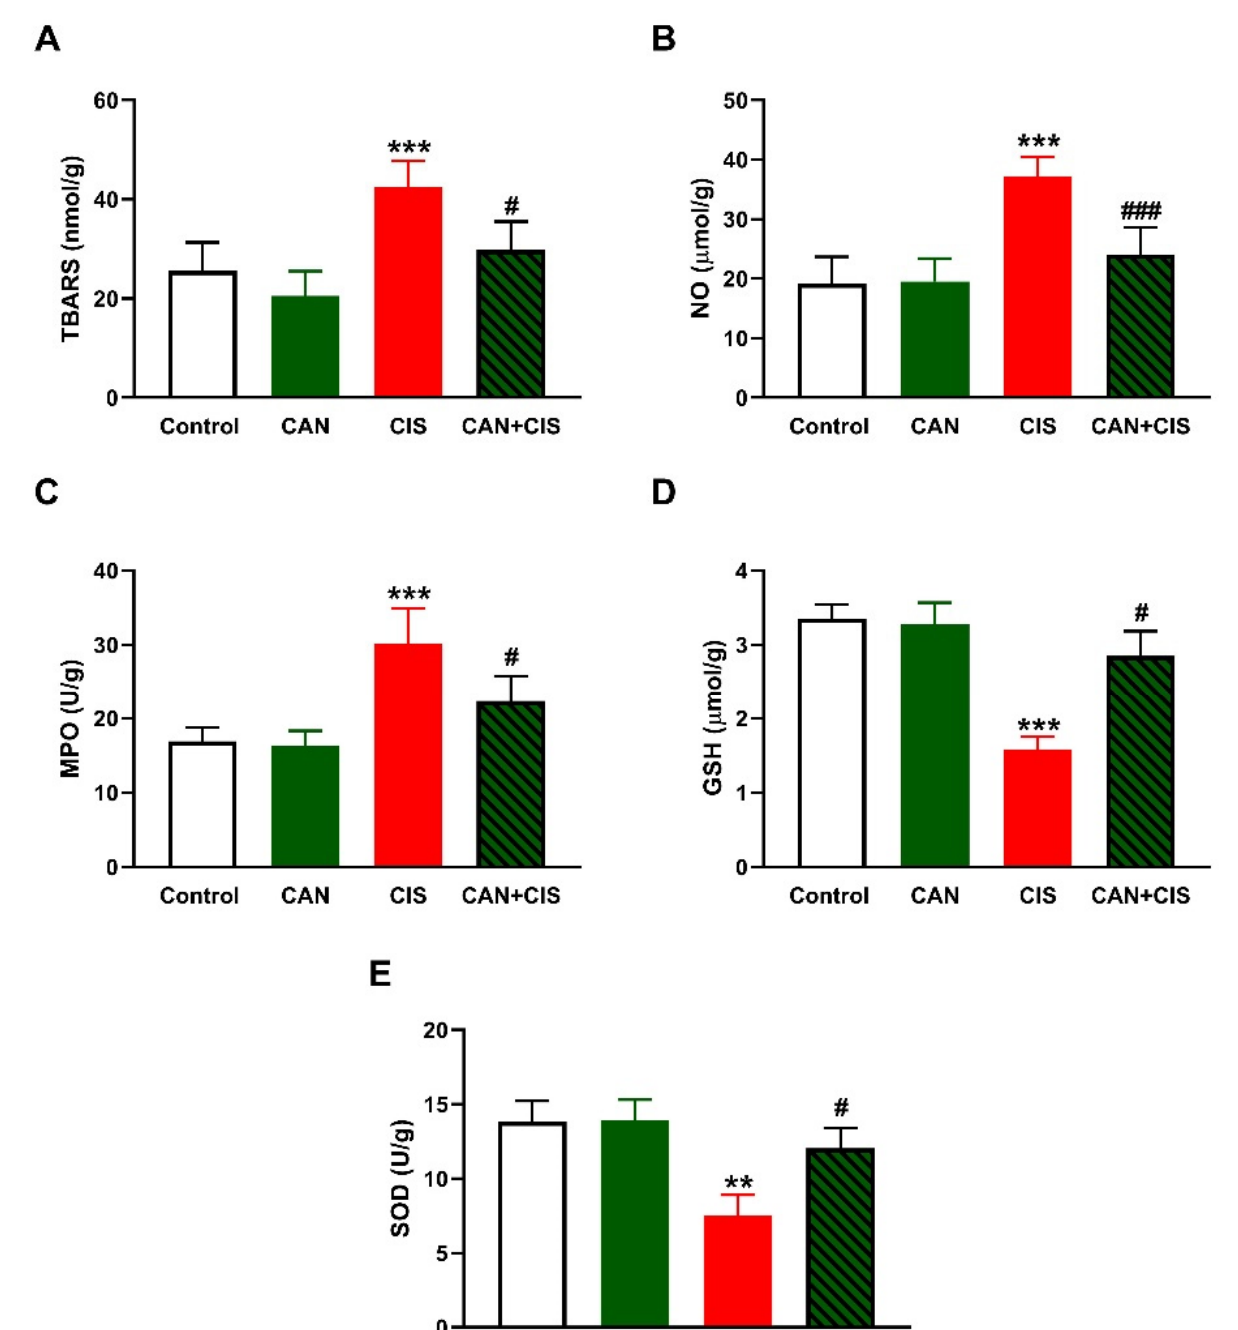
Figure 2. CAN attenuated CIS-induced oxidative stress in the lungs of rats. CAN decreased ( A ) TBARS, ( B ) NO, and ( C ) MPO activity, and increased ( D ) GSH and ( E ) SOD activity in CIS-administered rats. Data are Mean ± SEM, ( n = 8). ** p < 0.01 and *** p < 0.001 versus Control. # p < 0.05 and ### p < 0.001 versus CIS.